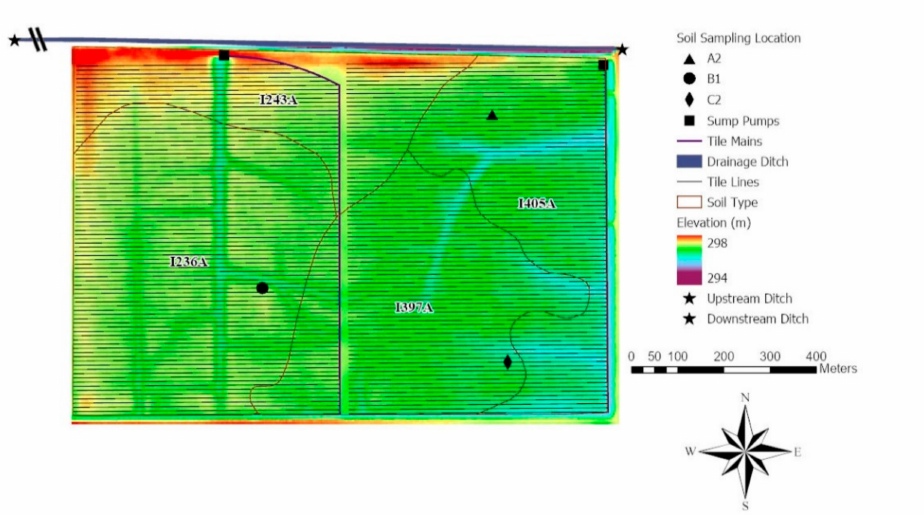
Figure 1. Experimental layout, where A2, B1, and C2 are soil sampling locations and the curved lines identify the soil map units, with I236A for Clearwater-Reis silty clays, I243A for Doran clay loam, I405A for Antler clay loam, and I397A for Antler-Mustinka complex,